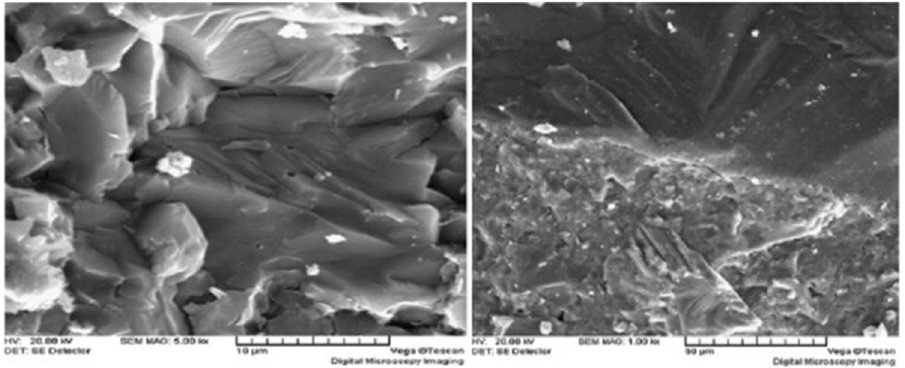
Figure 6: SEM micrograph of paste and ITZ of UHPC [ 54 ] .